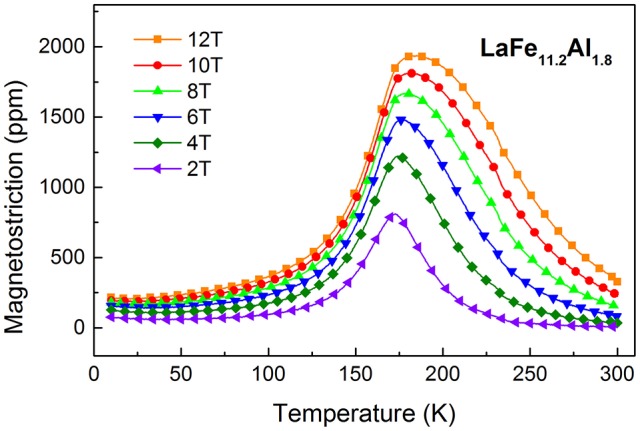
Temperature dependence of the magnetostriction λ(T) in LaFe11.2Al1.8 at different magnetic fields.